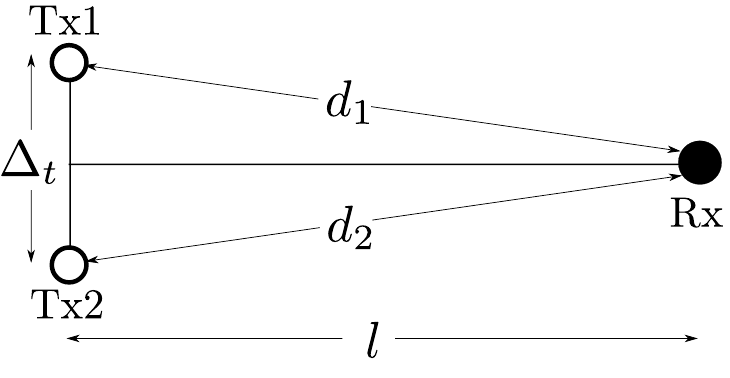
Figure 2. Network topology